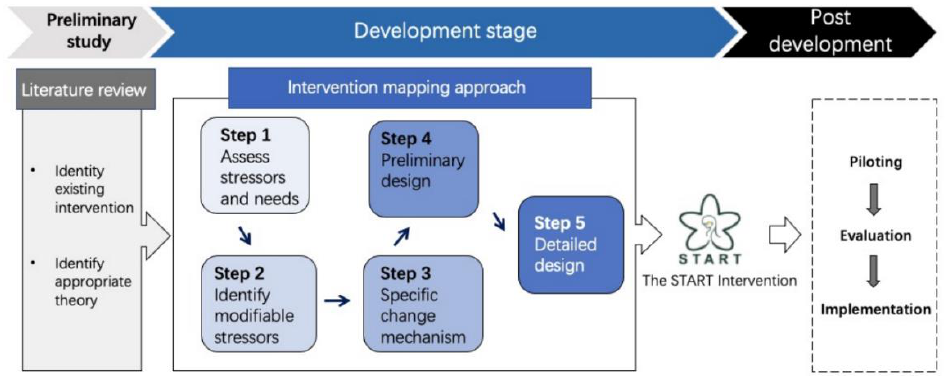
Figure 2. Flow diagram of the iterative development process [23,24].